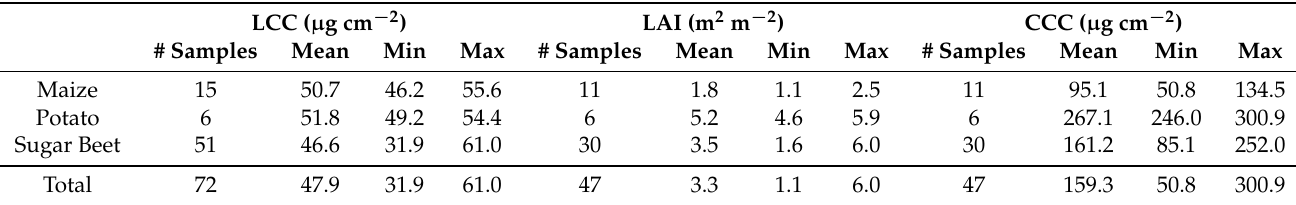
Table 2. Descriptive statistics of the in situ measurements used for validation. LCC and LAI were measured in different crop fields situated near Jülich (Germany) by means of a SPAD-502 Plus Chlorophyll meter (Konika Minolta Inc., Tokyo, Japan) and a SunScan photometer (Delta-T Devices, Cambridge, UK), respectively. The CCC measurements were computed by multiplying the LCC and LAI